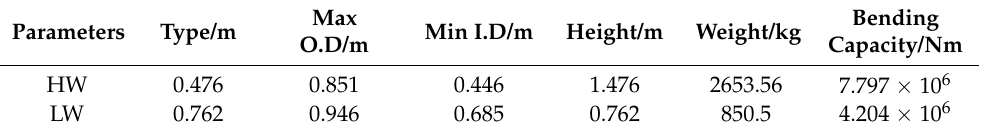
Table 1. Parameters of SS10